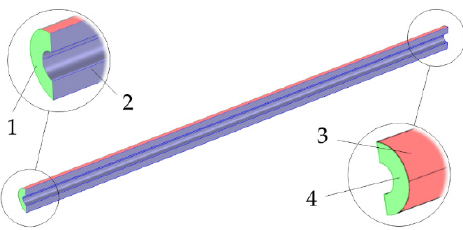
Figure 4. Geometric model of gas flow: 1—inlet; 2—reaction site; 3—heating side; 4—outlet.